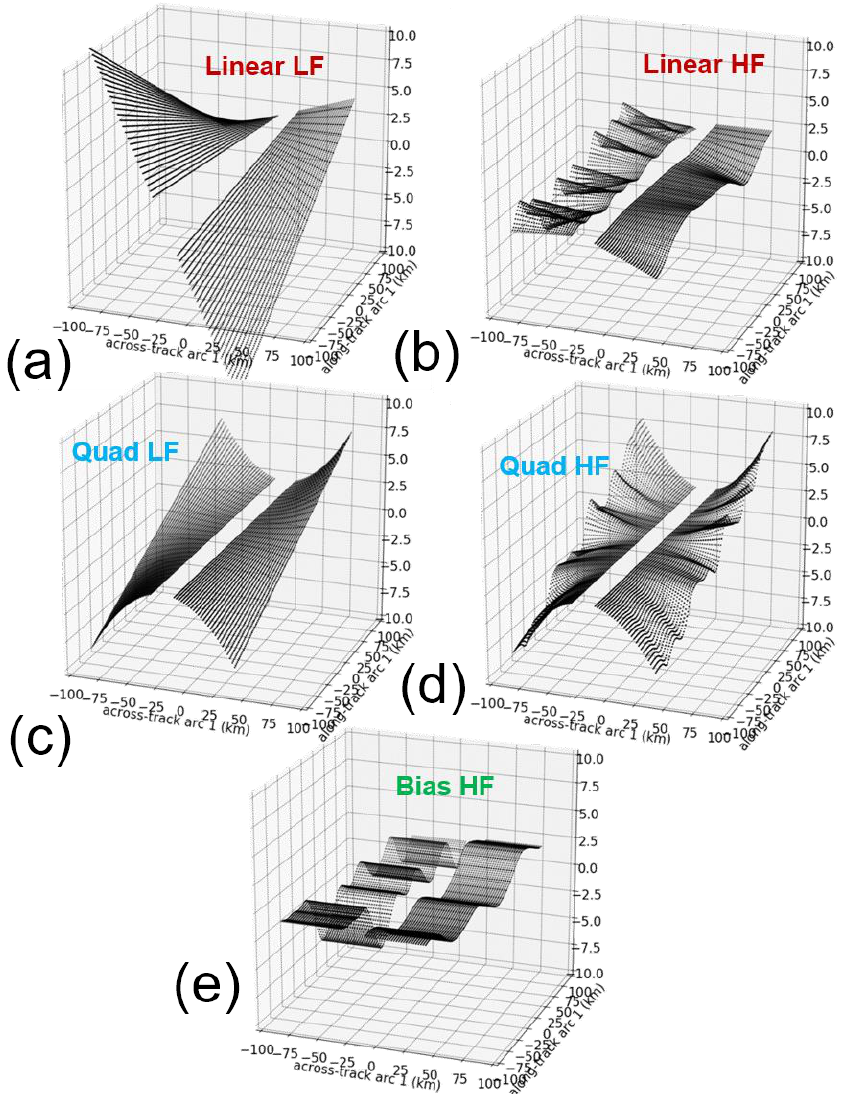
Figure 2. Qualitative examples of SWOT’s systematic errors. Panel ( a ) shows an example of low- frequency linear component. Panel ( b ) is the same for the high-frequency linear component. Panels ( c ) and ( d ) show the quadratic component for low-frequencies and high-frequencies respectively. Panel ( e ) shows an example high-frequency bias component.